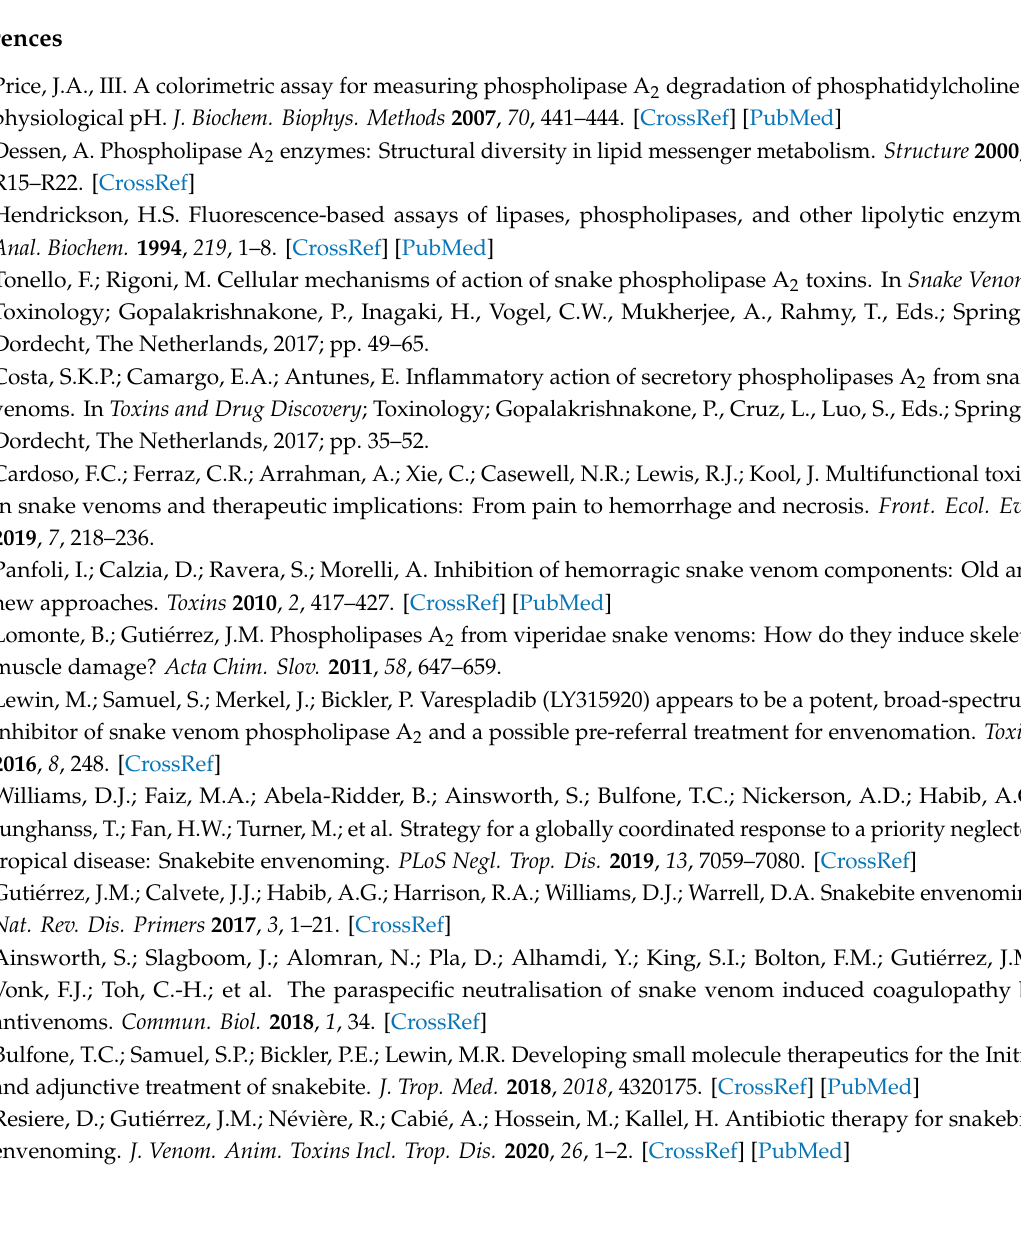
Figure S1. Duplicate PLA 2 bioactivity chromatograms of nanofractionated venom toxins, positive peaks indicate PLA 2 activity; Figure S2. Duplicate coagulopathic toxicity chromatograms of the nanofractionated venom toxins, anticoagulation is measured as negative signals and procoagulation as positive signals; Figure S3. Duplicate PLA 2 bioactivity chromatograms of B. asper , D. russelii , E. carinatus, and O. scutellatus venoms in the presence of various varespladib concentrations; Figure S4. Duplicate coagulopathic toxicity bioassay chromatograms of nanofractionated venom toxins from B. asper, C. rhodostoma, D. acutus, D. russelii, E. carinatus, E. ocellatus, and O. scutellatus in the presence of various concentrations of